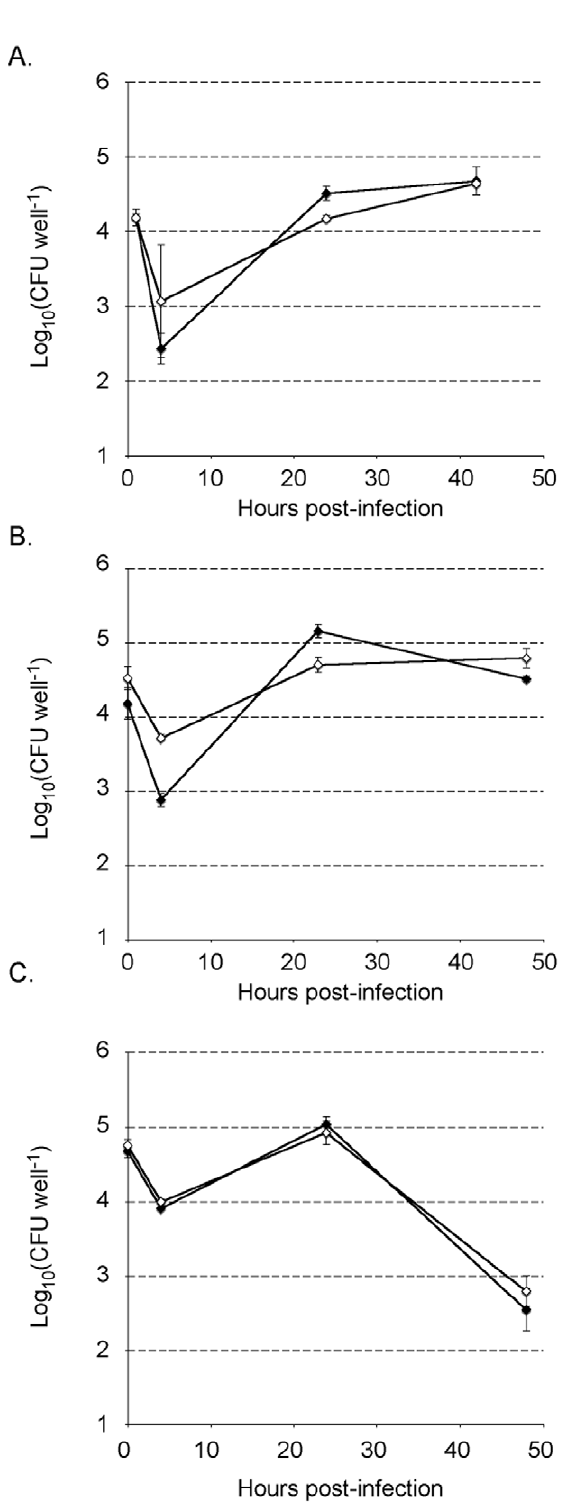
Figure 6. Intracellular replication of LVS and trkH strains. Intracellular bacterial replication was monitored over a 48 h-period in J774 macrophage like cells (A), in THP1 human macrophages (B), and in mouse bone marrow-derived macrophages (BMM) from BALB/c mice (C). Results are shown as the average of log 10 (CFU well 2 1 ) 6 standard deviation. Closed symbols designate the LVS strain and open symbols the trkH strain.